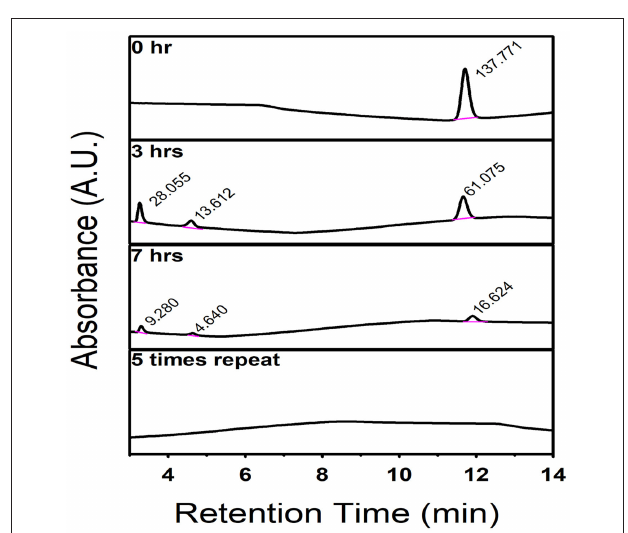
FIGURE 9 | HPLC spectrum showing the degradation of 4-nitrophenol by C, N-TiO 2 , the intermediate compounds formation after 3h irradiation and the complete degradation after 5 repeated